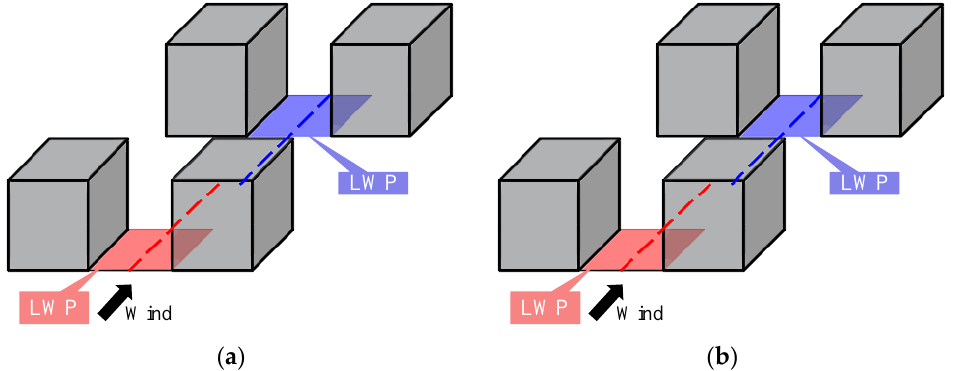
Figure 2. The location diagram of the two typical wind passages of a building array. ( a ) Distorted wind passage. ( b ) Streamlined wind passage. The local wind passages between two buildings are named